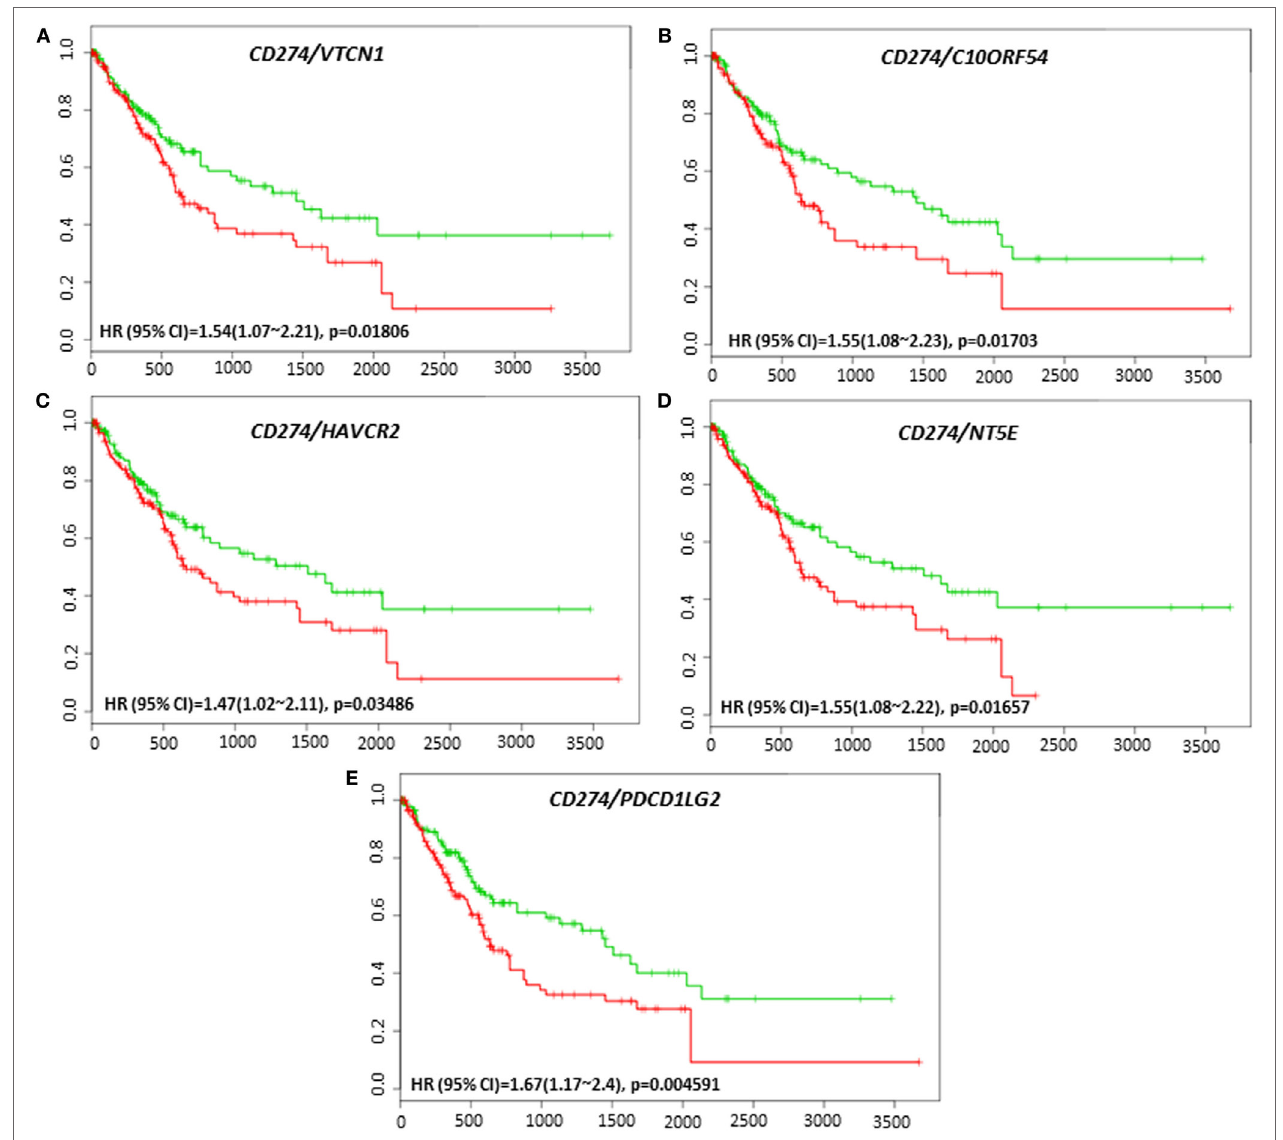
FigUre 6 | Relationship of immune modulators in combination with PD-L1 (CD274) and recurrence-free survival in HCC patients. Kaplan–Meier curves produced using the SurvExpress for the analysis of recurrence-free survival and gene expression of (a) CD274/VTCN1 , (B) CD274/C10ORF54 , (c) CD274/HAVCR2 , (D) CD274/NT5E , and (e) CD274/PDCD1LG2 in HCC patient samples. Green curve represents low-risk group, while red curve represents high-risk group. The study time (months) is presented in the x -axis. The insert shows the hazard ratio, confidence interval, and Log-Rank Equal Curves p value. Markers ( + ) represent censoring